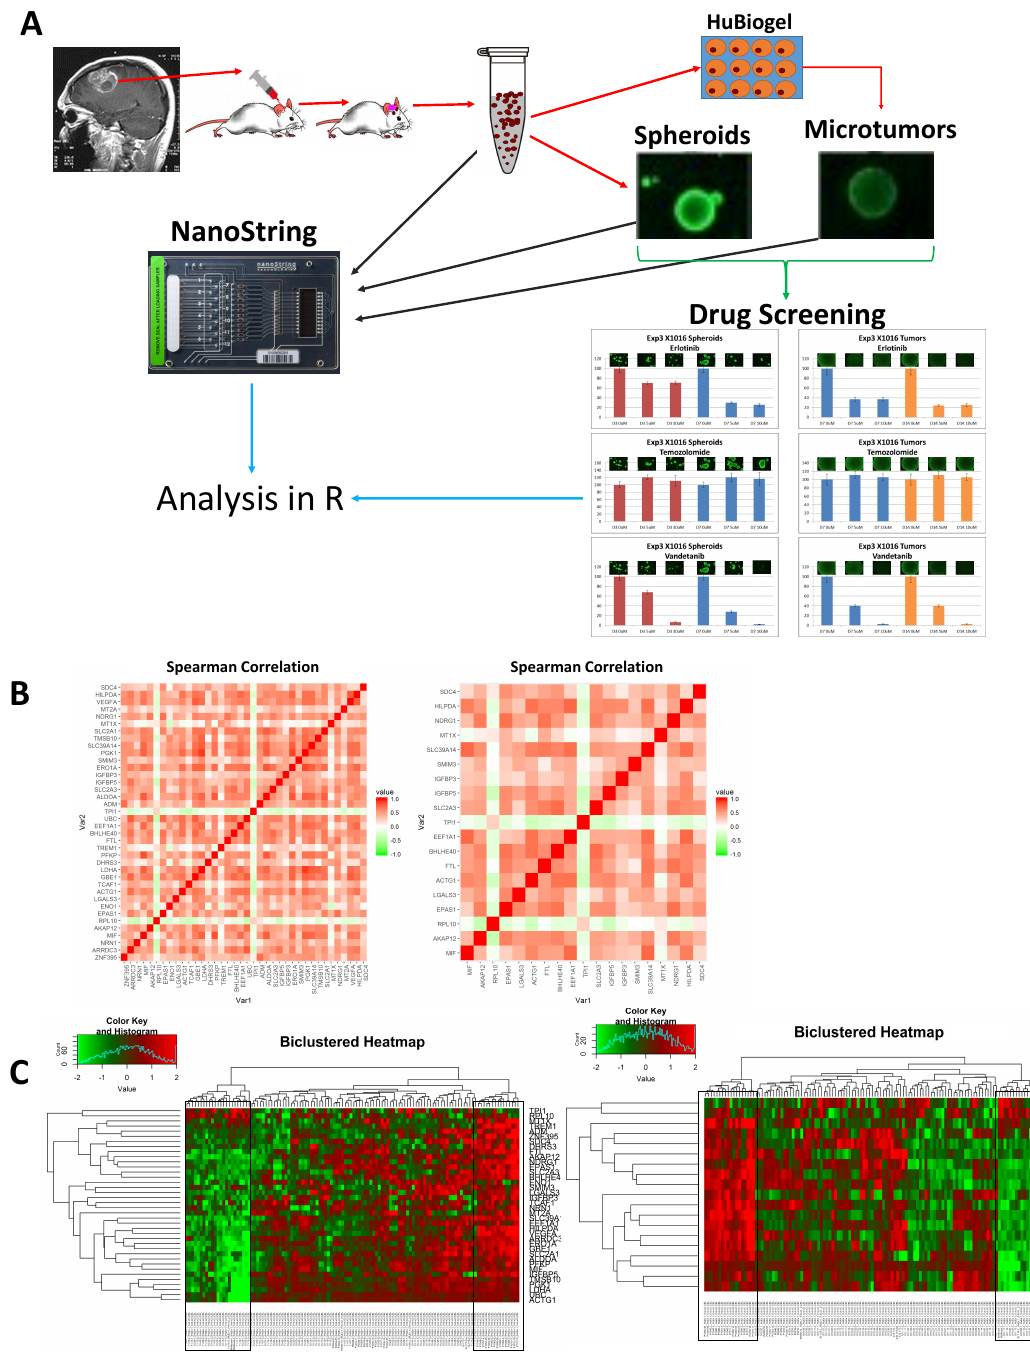
Figure 1. Study methods and representation of NanoString signature construction: ( A ) Graphical representation of workflow. R analysis includes di ff erential expression, correlation, and clustering analysis; ( B )Spearmancorrelationofgenesinhypoxiasignaturebefore(left)andafter(right)dimensional reduction; ( C ) Heatmap of samples clustered using genes from original 40 gene hypoxia signature (left) and heatmap of samples clustered using genes from dimensionally reduced 19 gene signature. Boxes highlight groups of samples with high average expression and low average